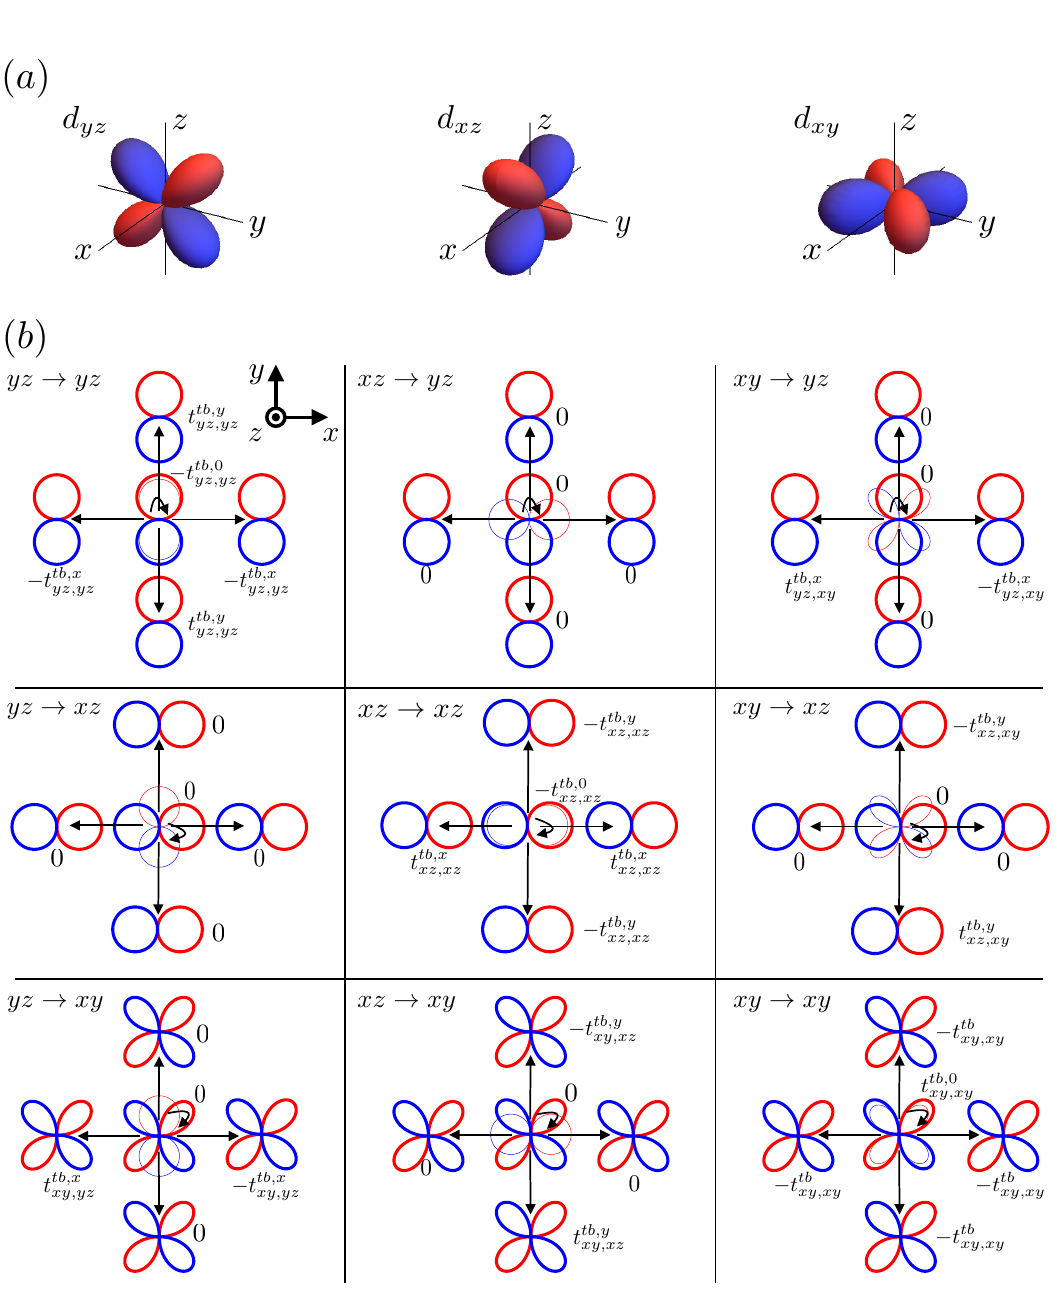
Figure 11: (a) The different t orbitals and their orientation. (b) The possible tunneling 2 g paths between an orbital (thin lines) in the bottom layer to the nearest and and next nearest orbitals (thick lines) in the layer above. Also the corresponding matrix elements are shown. The orbitals are seen from